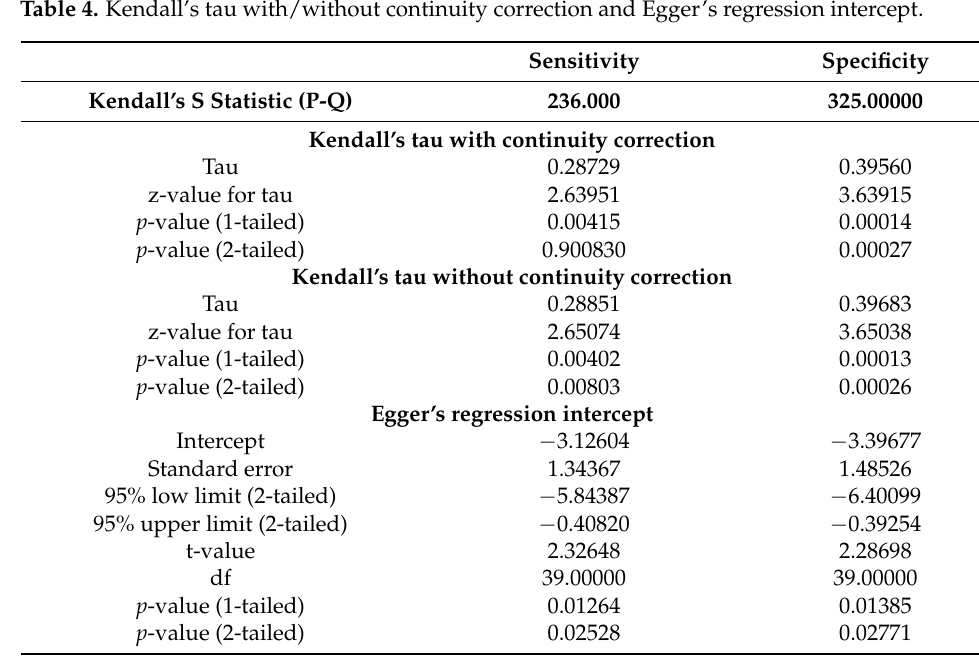
Figure 6. Pooled urea breath test result. Symmetric receiver operating characteristics (SROC) curve. Table 4. Kendall’s tau with/without continuity correction and Egger’s regression